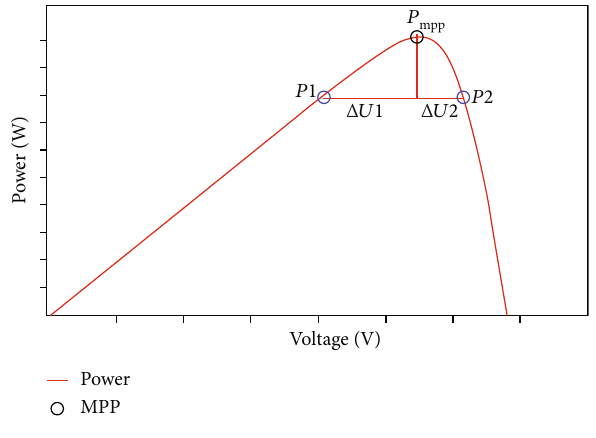
Figure 4: Tracking issues in the P – V curve.